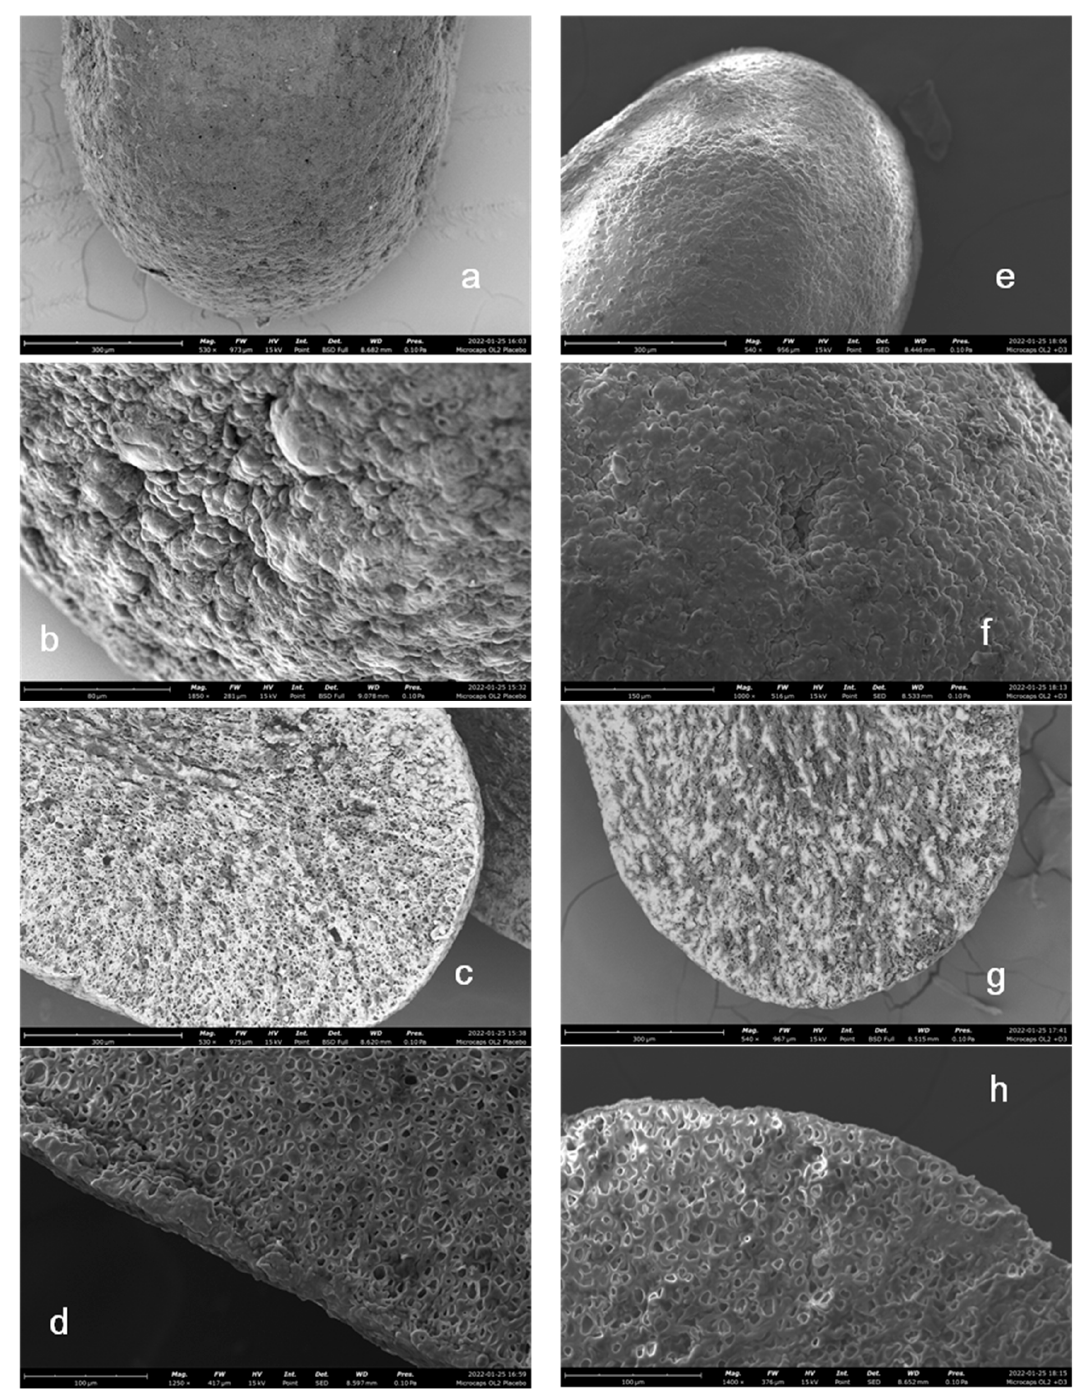
Figure 5. SEM images of the external surface (( a , b ), magni fi cation respectively 530× and 1850×) and a cross-section (( c , d ), magni fi cation respectively 530× and 1250×) of placebo microparticles; external surface (( e , f ), magni fi cation respectively 540× and 1000×) and a cross-section (( g , h ), magni fi cation respectively 540× and 1400×) of vit D3-loaded systems.